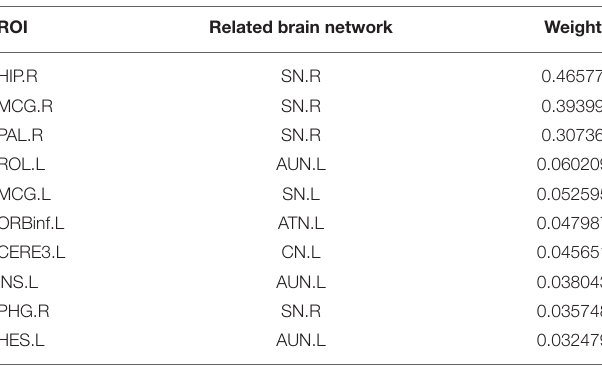
TABLE 5 | Top 10 ROIs of gray matter volume identified by our